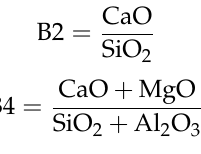
Table 1. Chemical composition (in wt.%) and basicity of the